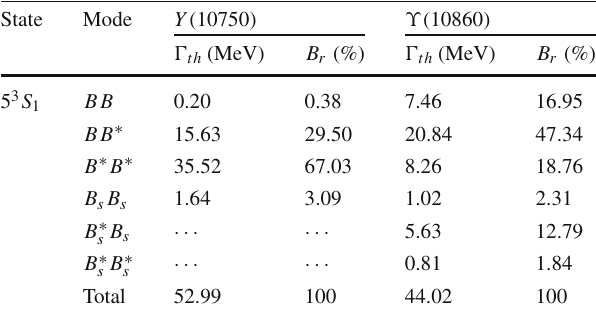
Table 5 Strong decays for the ϒ( 5 S ) which is assigned to be Y ( 10750 ) or ϒ( 10860 ) within the screened potential